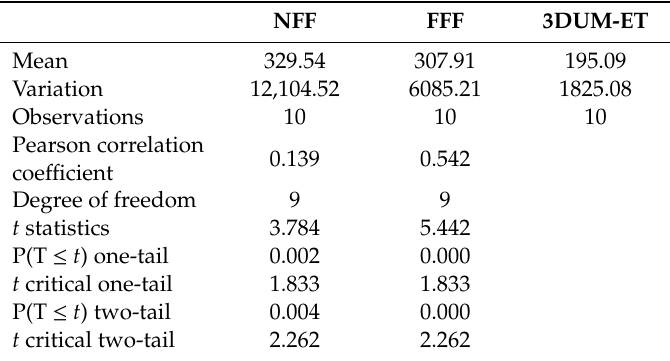
Table 13. Results of paired t